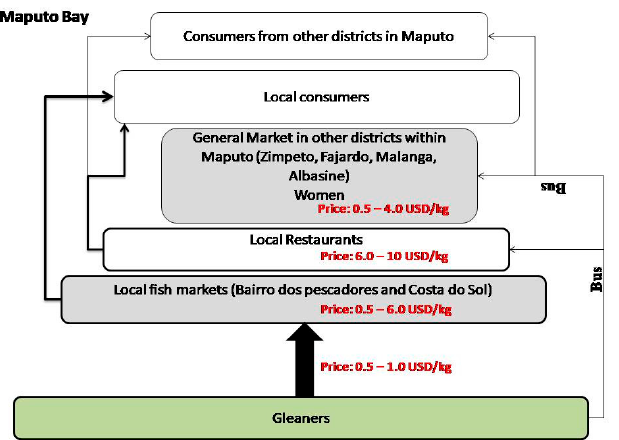
Figure 3. Illustration of the value chain: stakeholders, product flow, and market price variation between stakeholders for Bairro dos Pescadores (western MB) resources. Line thickness indicates the volume of resources transacted (thicker lines indicate higher volumes; thinner lines indicate lower volumes). Gleaners use buses to arrive at the marketplaces.